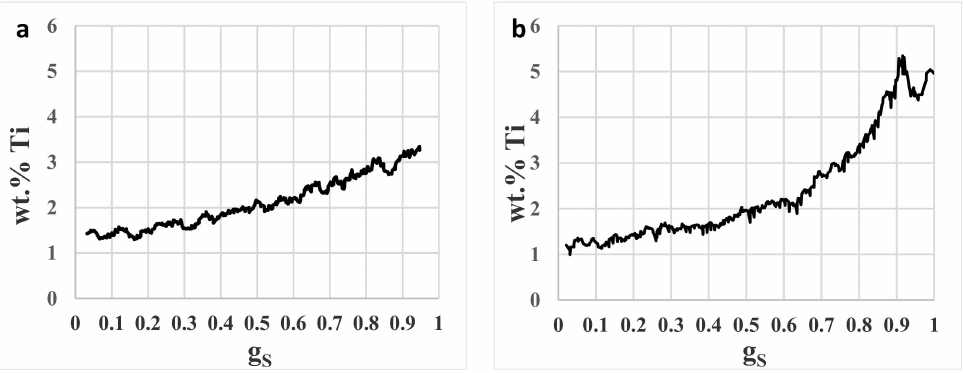
Figure 17. Measured Ti content at ( a ) 15 mm and at ( b ) 60 mm from the